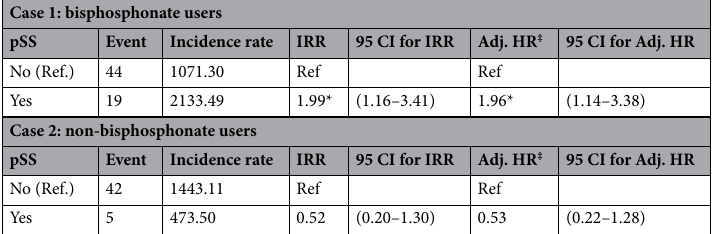
Table 2. Analysis of the Cox Proportional Hazard Model with cluster data for bisphosphonate and non- bisphosphonate users in pSS cohorts. (1) *0.01 ≤ p < 0.05, **0.0001 ≤ p < 0.01, *** p < 0.0001. (2) ‡ ADJ. HR was adjusted by sex, comorbidities, and age at the initiation of bisphosphonate use. pSS primary Sjogren syndrome, IRR incidence rate ratio, 95 CI 95% confidence interval, Adj. HR adjusted hazard ratio, Ref